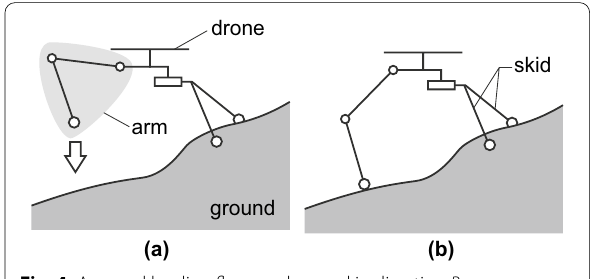
Fig. 4 Arm and landing flow as observed in direction B